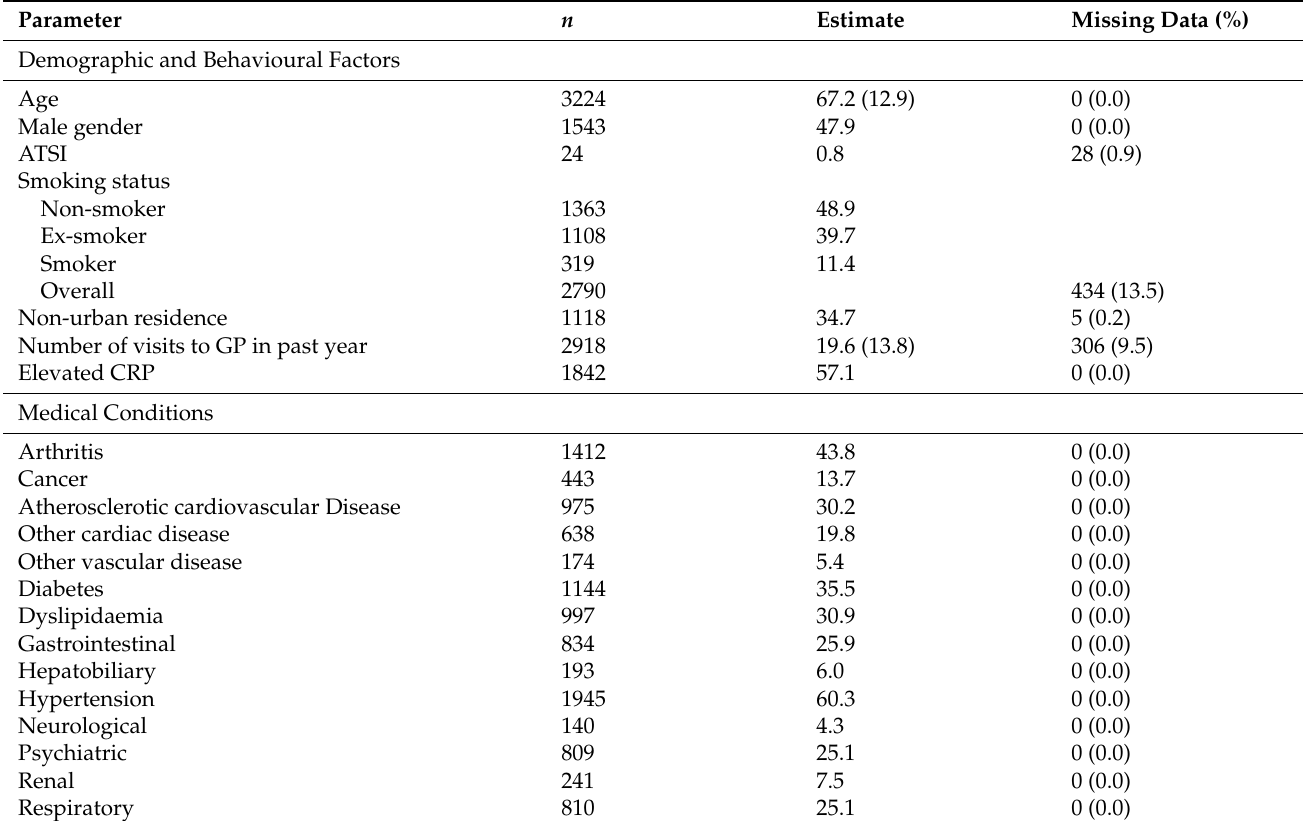
Table A8. Baseline characteristics of the participants from the ePBRN